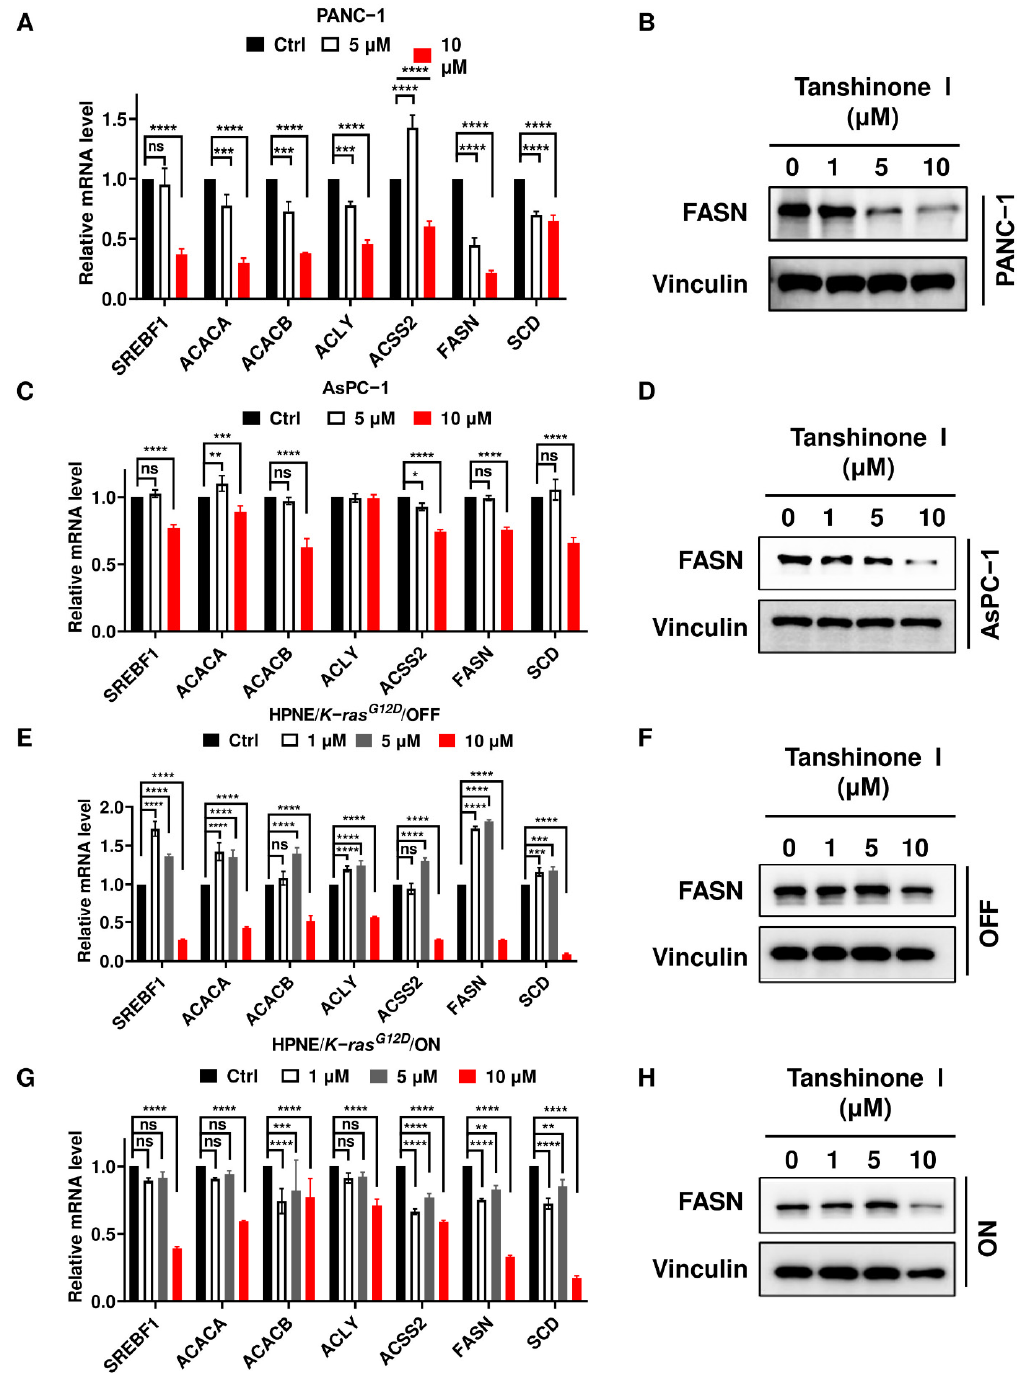
Figure 5. Tanshinone I treatment reduces expression of FASN involved in de novo fatty acid synthesis. ( A ) PANC-1 cells were incubated with tanshinone I (5–10 µ M) for 72 h. The mRNA levels of fatty acid synthesis-related genes were quantified by qRT-PCR. ( B ) PANC-1 cells were incubated with tanshinone I (1–10 µ M) for 72 h. FASN protein level was analyzed by western blot analysis (representative of 3 independent experiments). ( C ) AsPC-1 cells were incubated with tanshinone I (5–10 µ M) for 72 h. The mRNA levels of fatty acid synthesis-related genes were quantified by qRT-PCR. ( D ) AsPC-1 cells were incubated with tanshinone I (1–10 µ M) for 72 h. FASN protein level was analyzed by western blot analysis (representative of 3 independent experiments). ( E ) HPNE/ K-ras G12D /OFF cells were incubated with tanshinone I (1–10 µ M) for 72 h. The mRNA levels of fatty acid synthesis-related